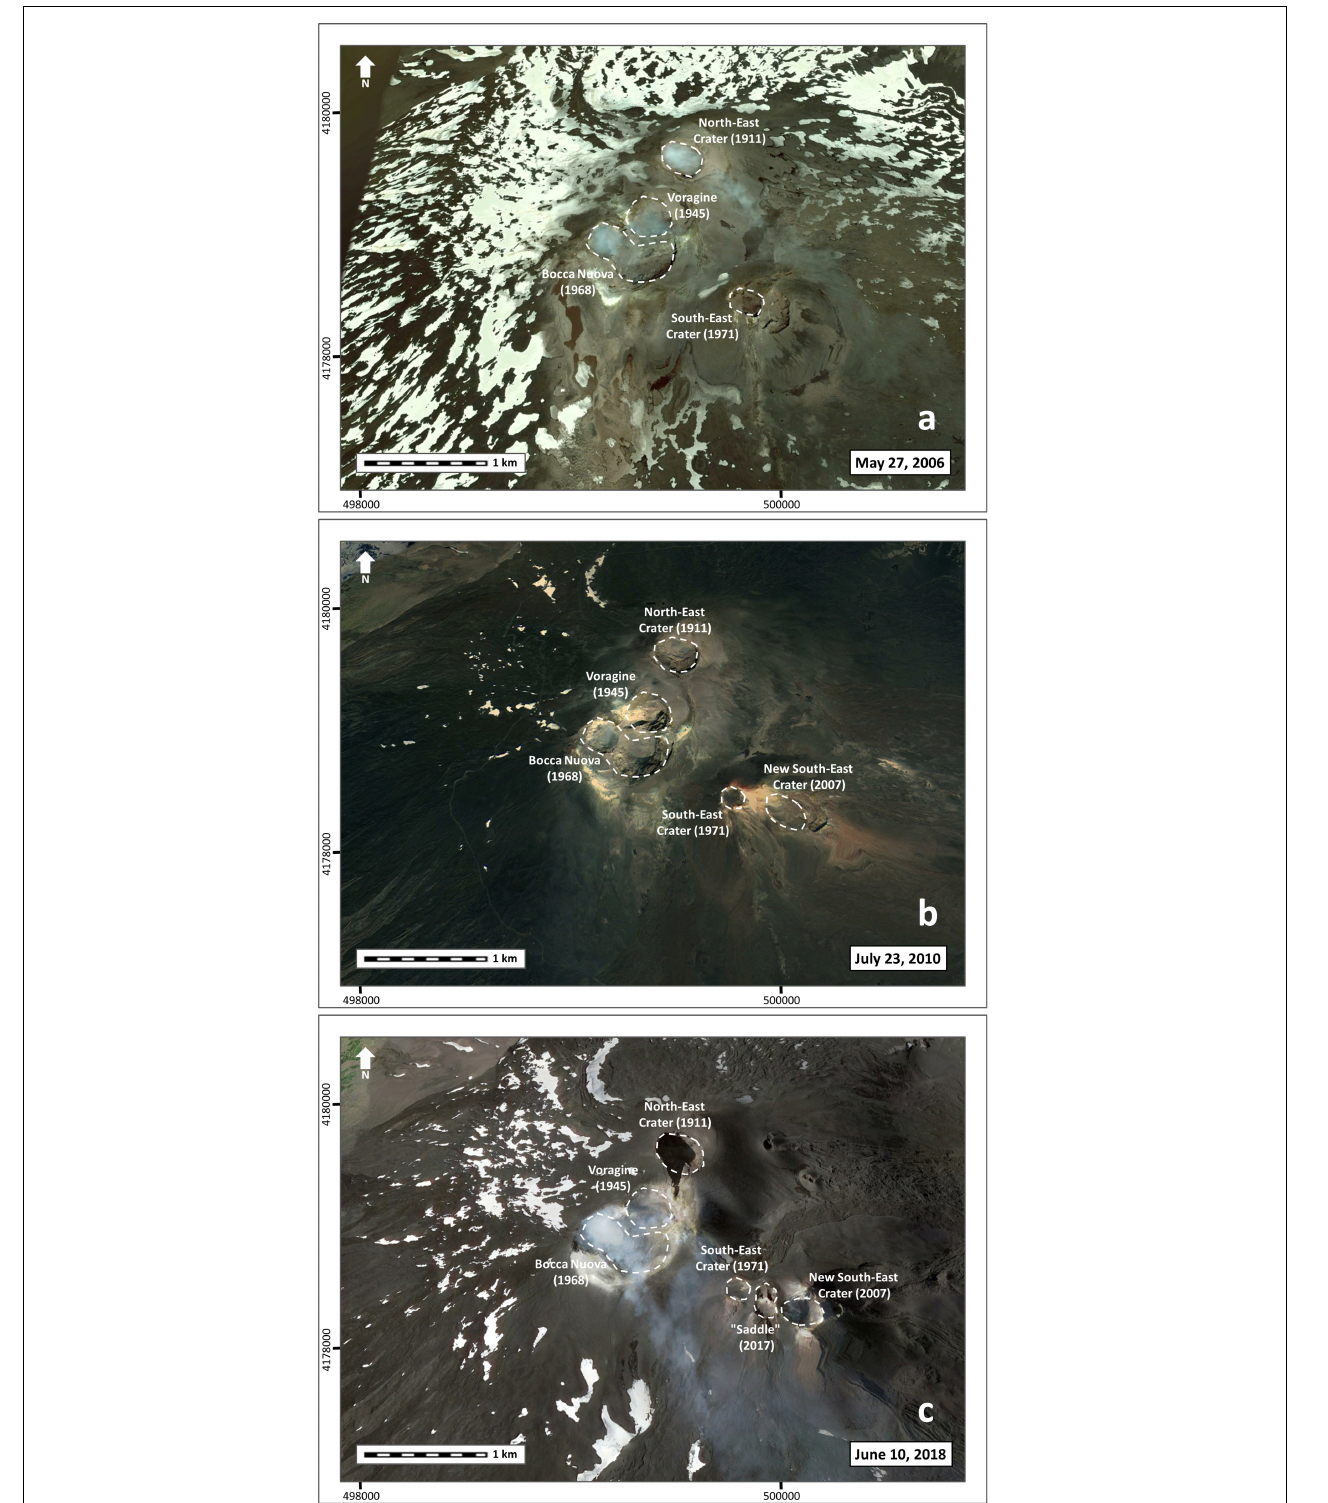
FIGURE 2 | Morphological change of the summit area of Mount Etna seen from Google Earth’s satellite imagery acquired on 27 May 2006 (a) , 23 July 2010 (b) and 10 June 2018 (c) . The three views highlight the formation and growth of the cones on the southeast flank of the volcano, which have produced exceptional eruptive episodes in the historical context of Etna’s